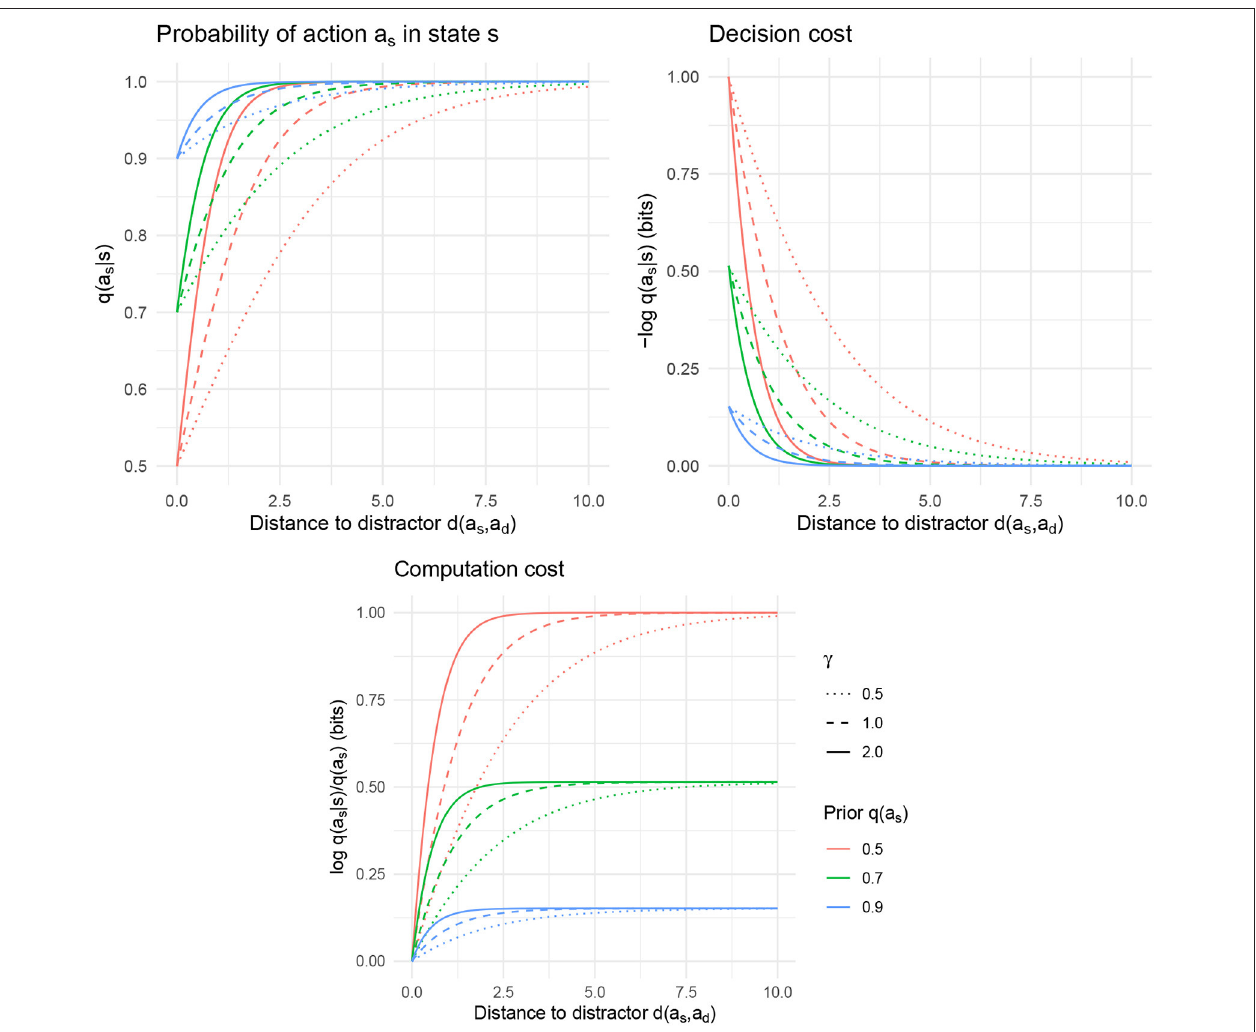
FIGURE 1 | Interference between a target action a s and a distractor a d as a function of the distance d ( a s , a d ), for varying values of resource parameter γ and the a priori probability q ( a s ). (Top left) The probability q ( a s | s ) of taking the appropriate action a s in state s . (Top right) The decision cost − log q ( a s | s ), which is high when a s and a d have low semantic distance. (Bottom) The computation cost log q ( a s | s ) q ( a s )